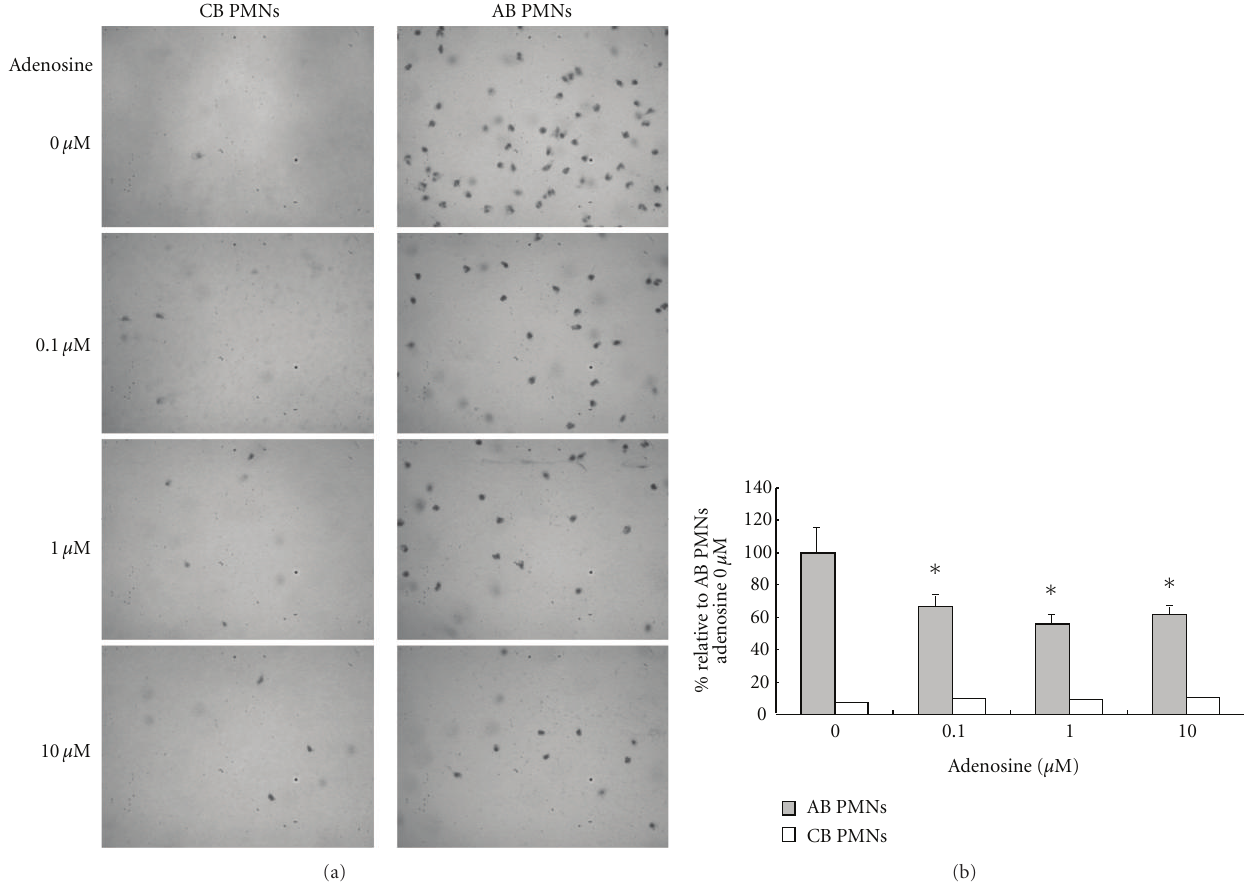
Figure 2: The modulating e ff ects of adenosine on chemotaxis of neonatal and adult PMNs. (a) Cord blood PMNs always had a lower chemotactic ability than adult PMNs upon fMLP stimulation. The results are representative of 6 duplicate experiments. (b) Plots illustrate chemotactic ability (expressed as numeral of number relative to adenosine 0 μ M in the ordinate) of adult and cord blood PMNs. The chemotactic ability of adult PMNs was decreased by about 40% at an adenosine concentration of 0.1 μ M (compared with adenosine 0 μ M). Data are expressed as mean ± SE. Abbreviations: AB PMNs: adult peripheral blood polymorphonuclear cells; CB PMNs: cord blood polymorphonuclear cells. Data presented are calculated from 6 duplicate experiments. ∗ P < 0 . 05 as compared with adenosine 0 μ